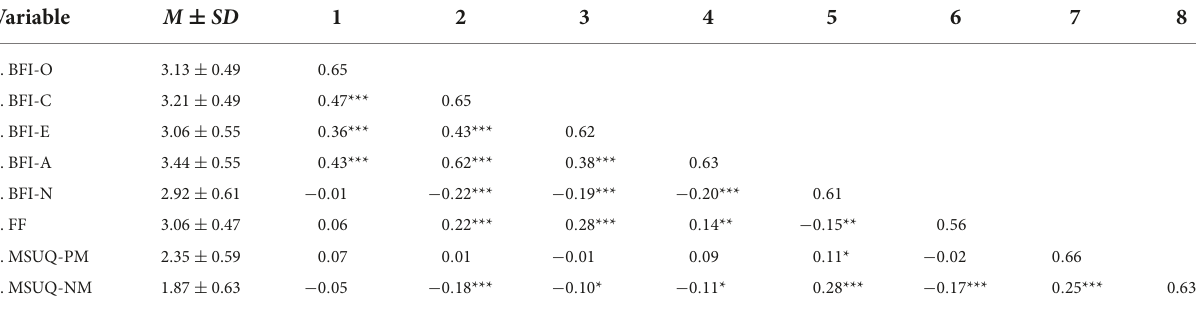
TABLE 1 Means, standard deviations, and correlations of the major variables.